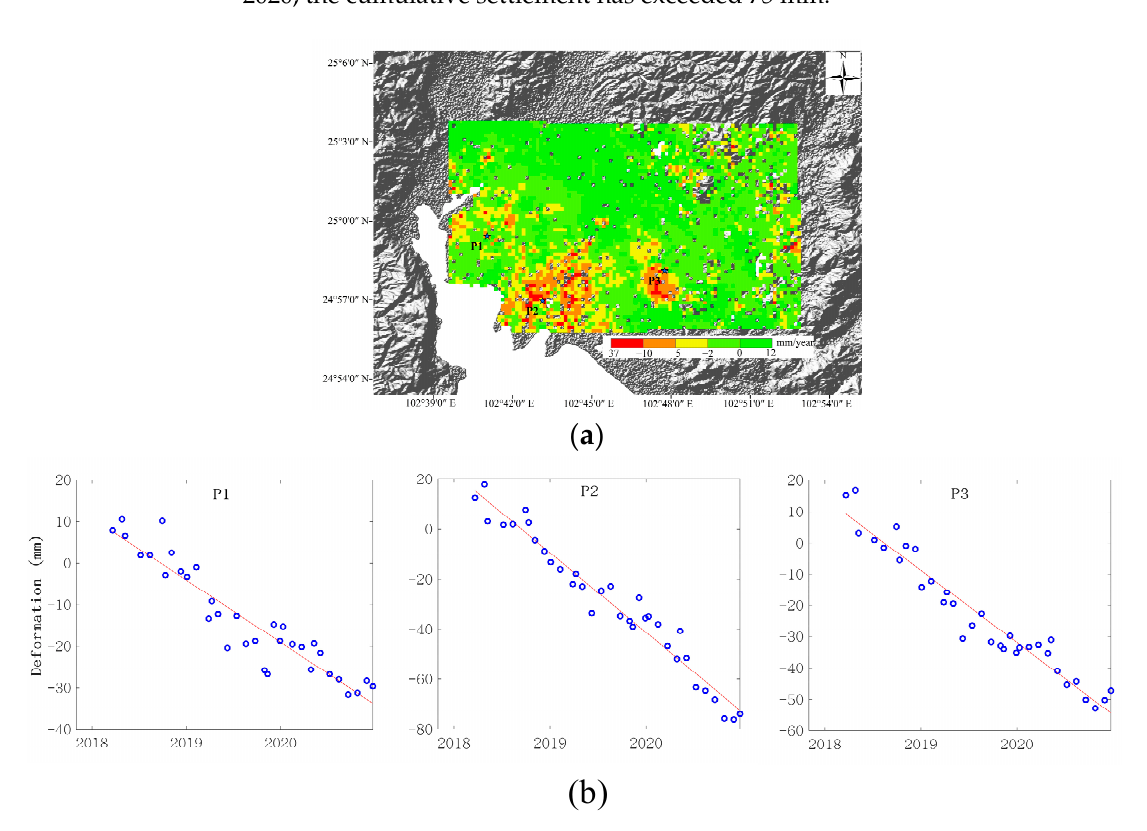
Figure 7. ( a ) Deformation rate in the northeast of Dianchi Lake ; ( b ) Time series cumulative settle- ment diagram of P1, P2 and P3 points. diagram of P1, P2 and P3 points.